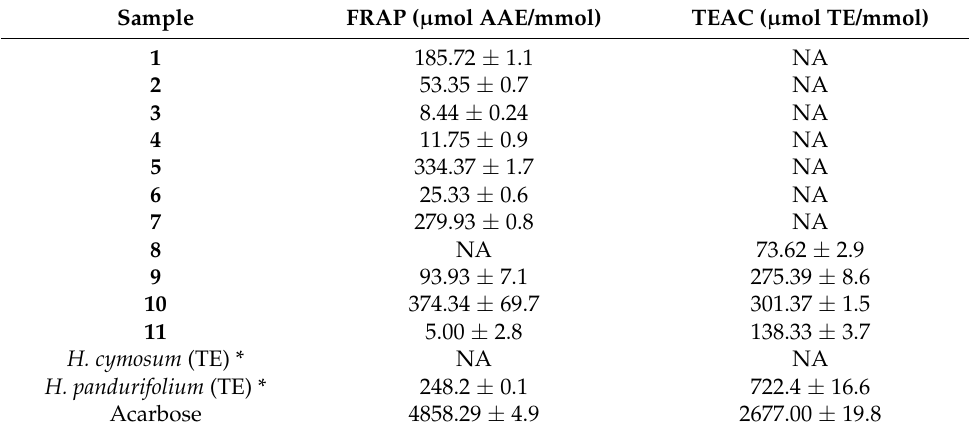
Table 2. Antioxidant activities of H . cymosum constituents and H. pandurifolium